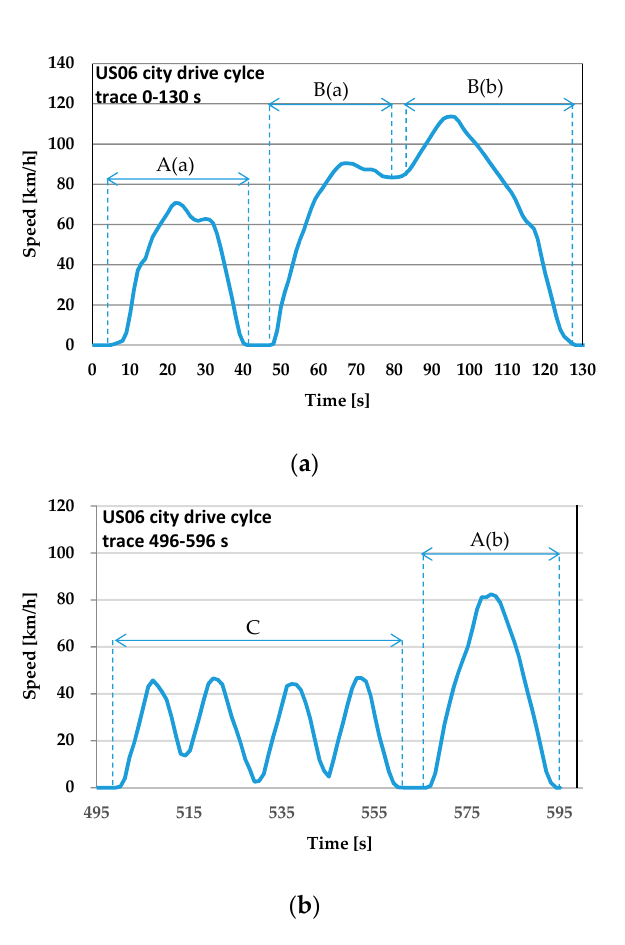
Figure 9. Velocity profile for city mode corresponding to the US06 driving cycles. (a) trace 0-130 s (b) trace 496-596 s